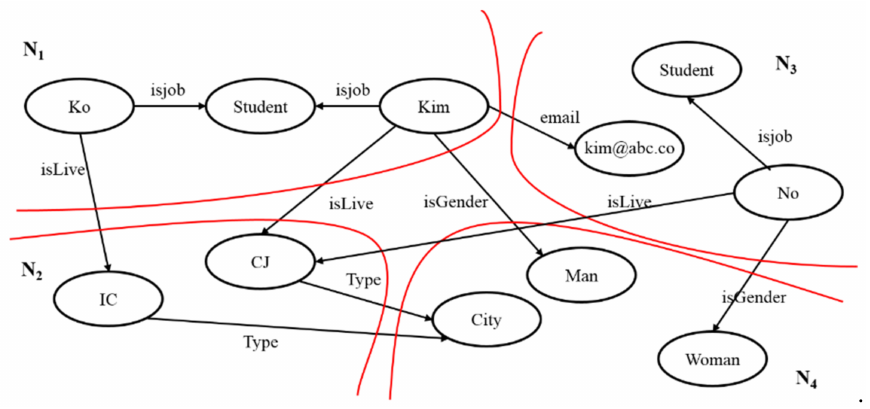
Figure 2. Example of an RDF